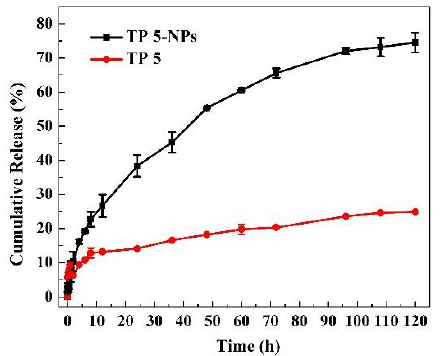
Figure 5. Drug release of free TP 5 and TP 5 -NPs in PBS containing 20.0% ethanol. Free TP 5 suspension was released ~20%, TP 5 showed quick release from TP 5 -NPs relative to free TP 5 suspension and 75.0% was released over 120 h. Abbreviations: TP 5 ; thiophene derivatives; TP 5 -NPs, TP 5 -loaded nanoparticles.